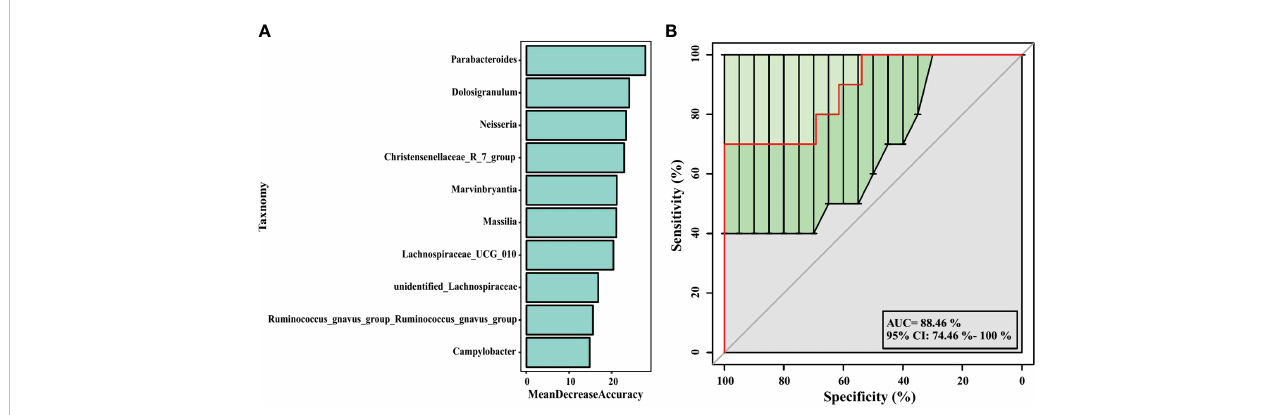
FIGURE 7 Prediction model of the airway microbiota for atopic wheezing status based on the genus-level relative abundances using random forests. (A) variable importance ranking chart, Mean Decrease Accuracy measures the degree to which the prediction accuracy of a random forest decreases by changing the value of a variable to a random number. A higher value indicates that the variable is more important. (B) ROC curve of the atopic wheezing model using 10 discriminatory genus. AUC, the area under the curve; ROC, receiver operating characteristic.